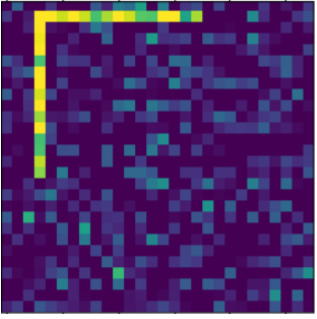
Figure 20. Moved object, with level 2 noise.